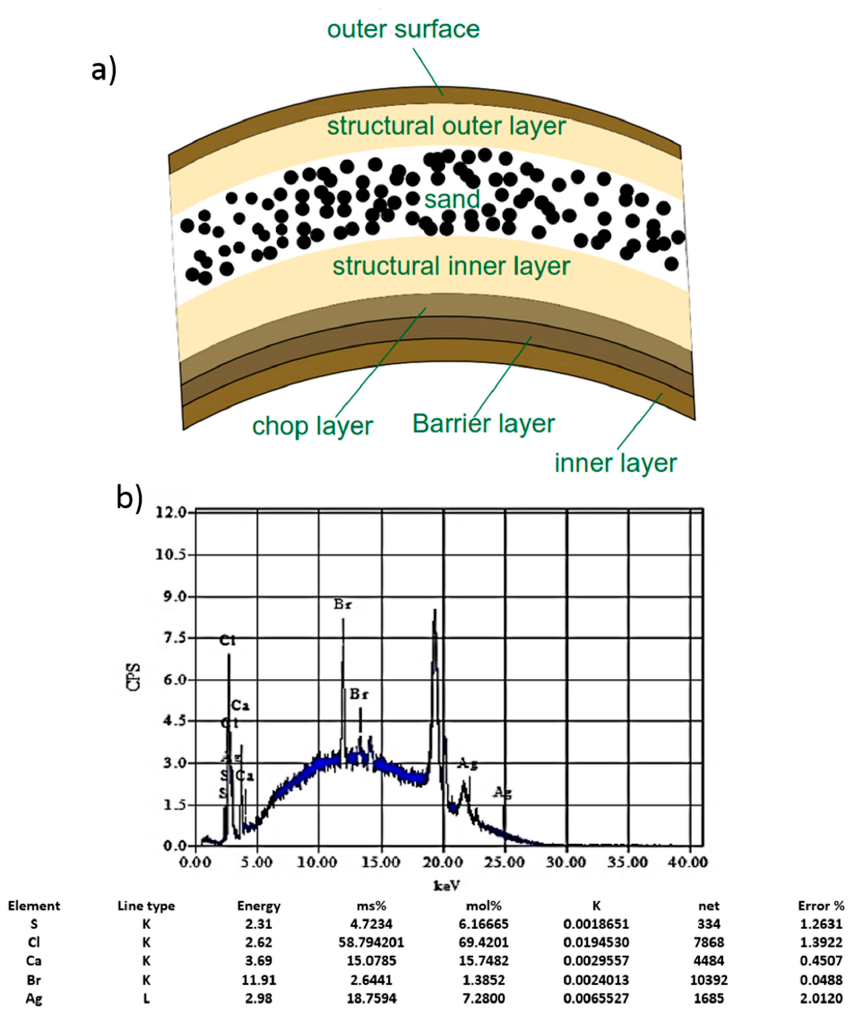
Figure 1. GRP wastewater system; ( a ) GRP schematic [20] and ( b ) chemical analysis of a wastewater petroleum sample.